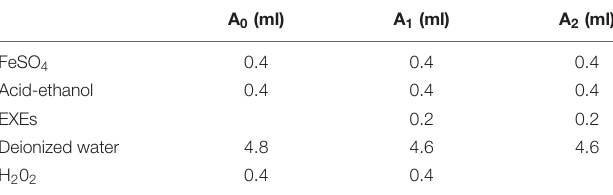
TABLE 1 | Hydroxyl radical scavenging reagent addition